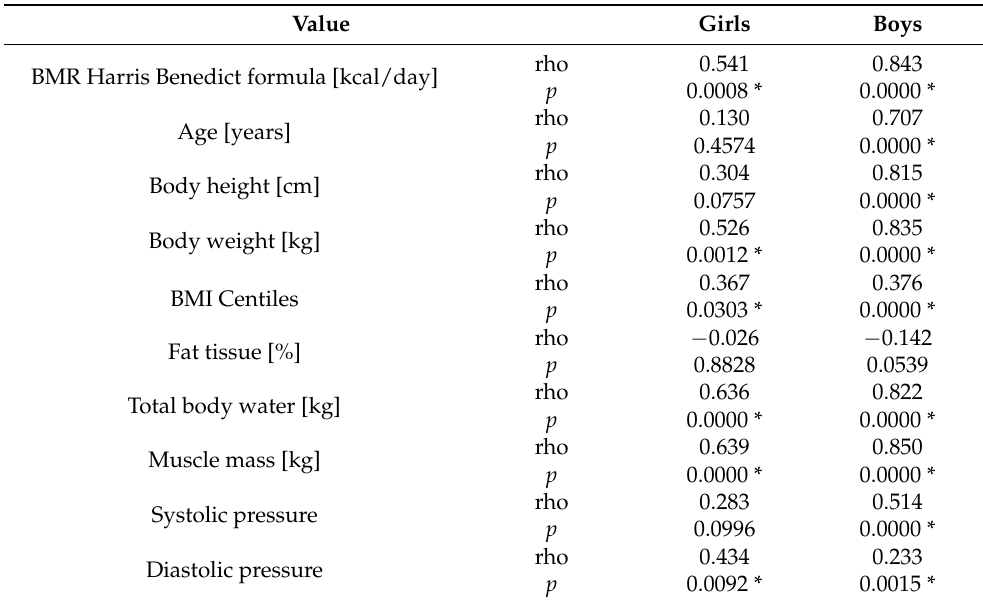
Table 2. Correlation between the resting energy expenditure (REE) and the selected factors.